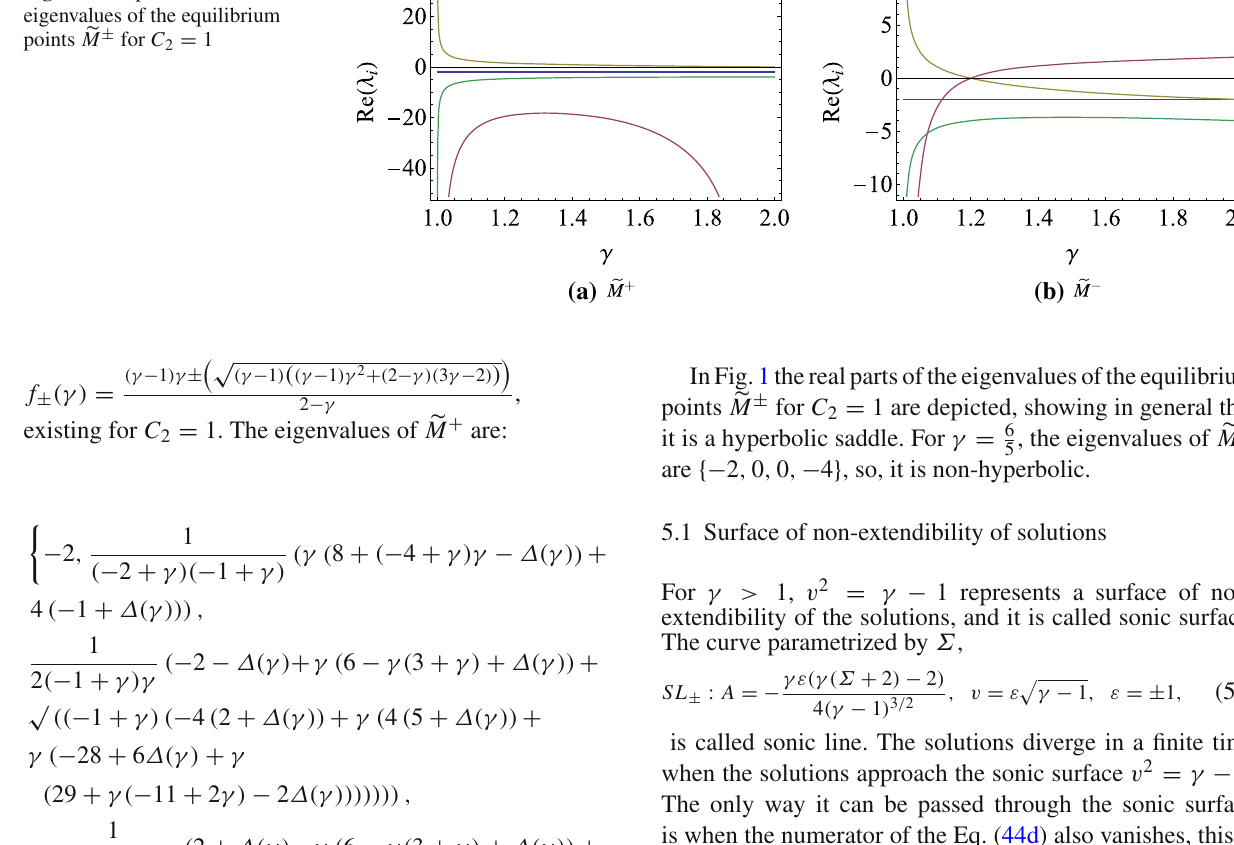
Fig. 1 Real parts of the eigenvalues of the equilibrium points (cid:25) M ± for C 2 =